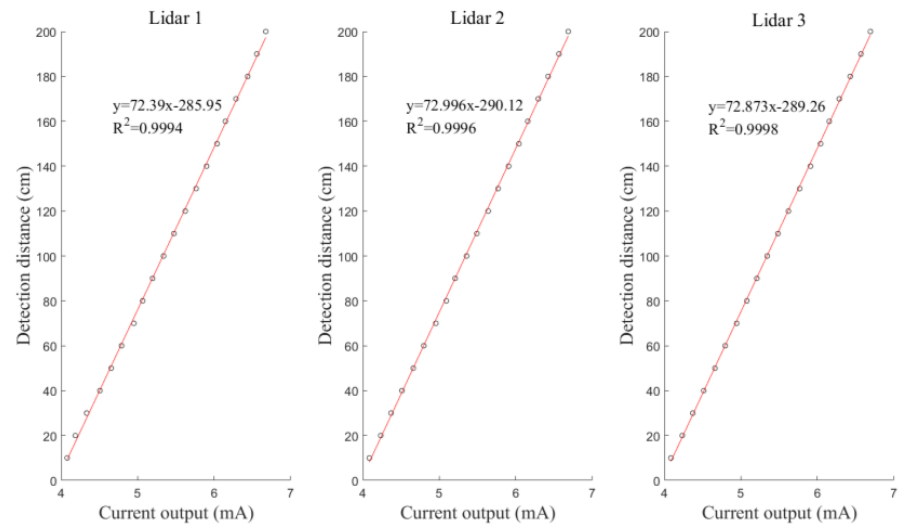
Figure 7. Calibration curves of the LiDAR sensors: where x is the output current, mA, and y is the actual distance, cm.